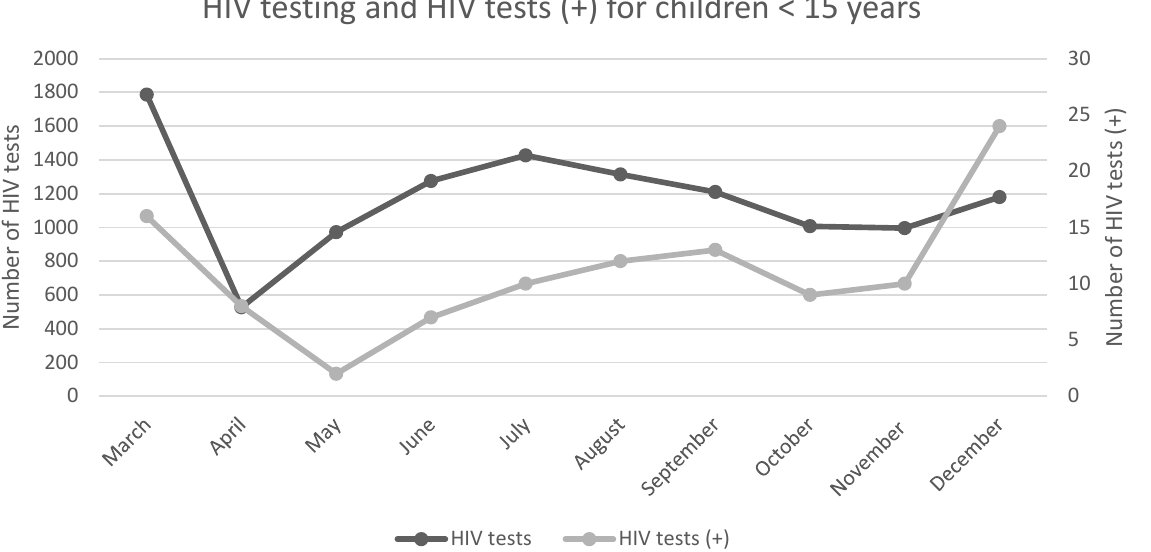
Figure 5. Line graph illustrating the annual number of HIV tests conducted in each province of South Africa, from 2018 until the end of 2020. Data was collected from the National Department of Health website, and represents HIV testing trends in the public health sector [17]. Each point repre- sents the number of HIV tests conducted in the province for that specified year. The trend lines show that between 2018 and 2020, HIV testing in every province increased. In contrast, the trend line for 2020 – 2021 fell much lower than previous years. No significant change in HIV testing can be seen for Free State and the North West, however, Gauteng experienced the most drastic decline between 2019 – 2020 and 2020 – 2021.